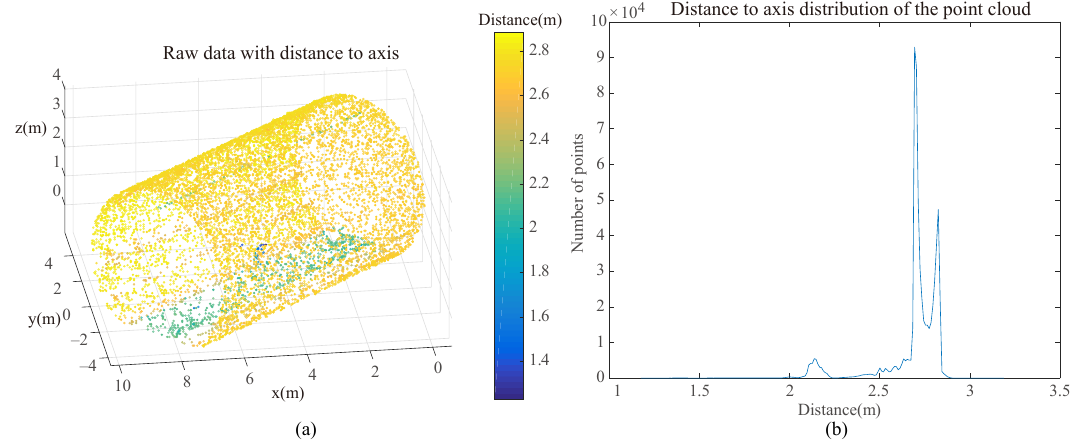
Figure 10. Distance distribution of raw point clouds in experiments: ( a ) illustrates the three-dimensional spatial distribution of the tunnel point cloud about distance; ( b ) illustrates the quantity distribution of the tunnel point cloud about distance.